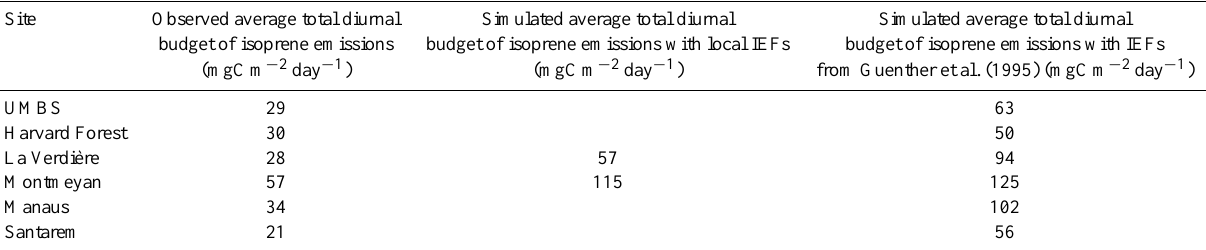
Table 3. Observed and simulated average total diurnal budget of isoprene emissions at the flux tower sites listed in Table 1.